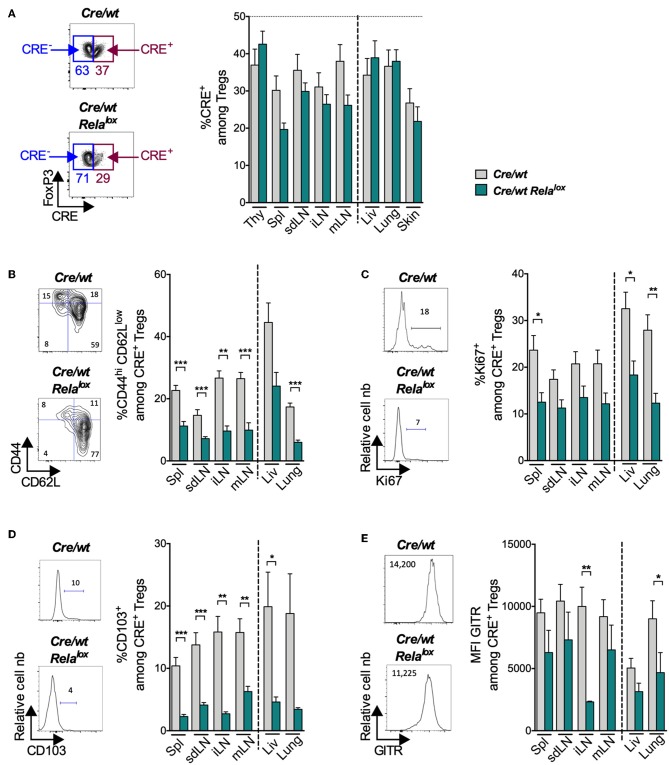
Reduced expression of activation markers in RelA-deficient Tregs at steady state. Analyses in the indicated organs (thy, thymus; spl, spleen; liv, liver) of 8 week-old Foxp3Cre/wt (Cre/wt – gray bars) and Foxp3Cre/wt
Relalox (Cre/wt Relalox–green bars) mice. (A) Representative density plots among CD4+ cells to define Tregs expressing CRE (CRE+) and percentages of CRE+ among total Tregs in sdLN. Representative density plots and proportions of CD44hi CD62Llow
(B), Ki67+
(C), CD103+
(D) and MFI of GITR (E) among CRE+ Tregs of sdLN. Bars show the means of pooled independent experiments and error bars represent SEM. For mouse and experiment numbers, see Supplementary Table 1. The two-tailed unpaired nonparametric Mann–Whitney U-test was used. *p < 0.05, **p < 0.01, ***p < 0.001.